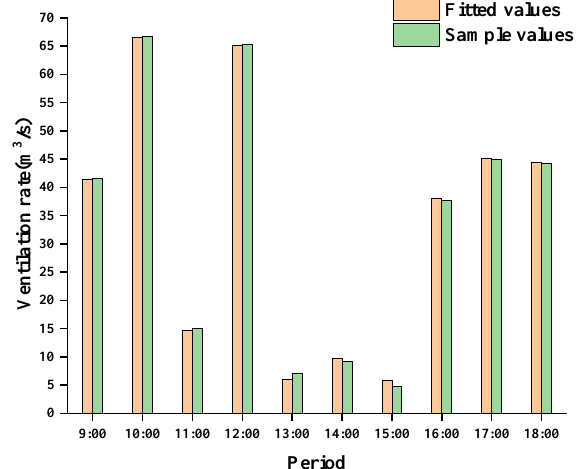
Figure 21. Comparison of the fitted and sample values in the high-altitude area.